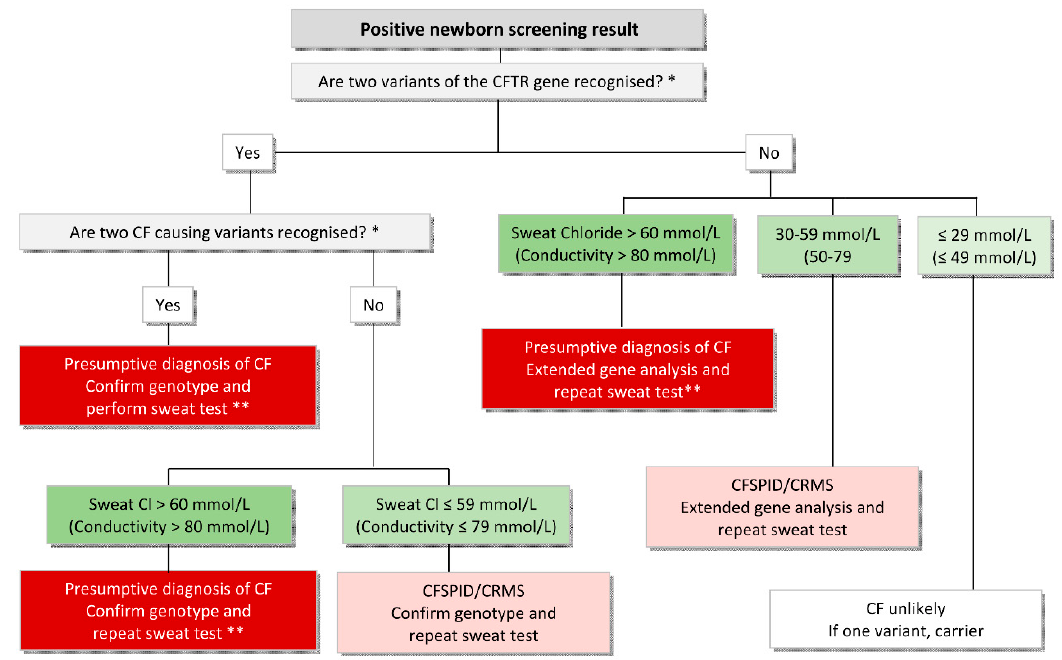
Figure 2. Diagnostic algorithm after a positive NBS result in the CF centre. * According to the CFTR2 website. ** Infants at this point have a presumptive diagnosis of CF and treatment should be established. Further testing is required to consolidate the